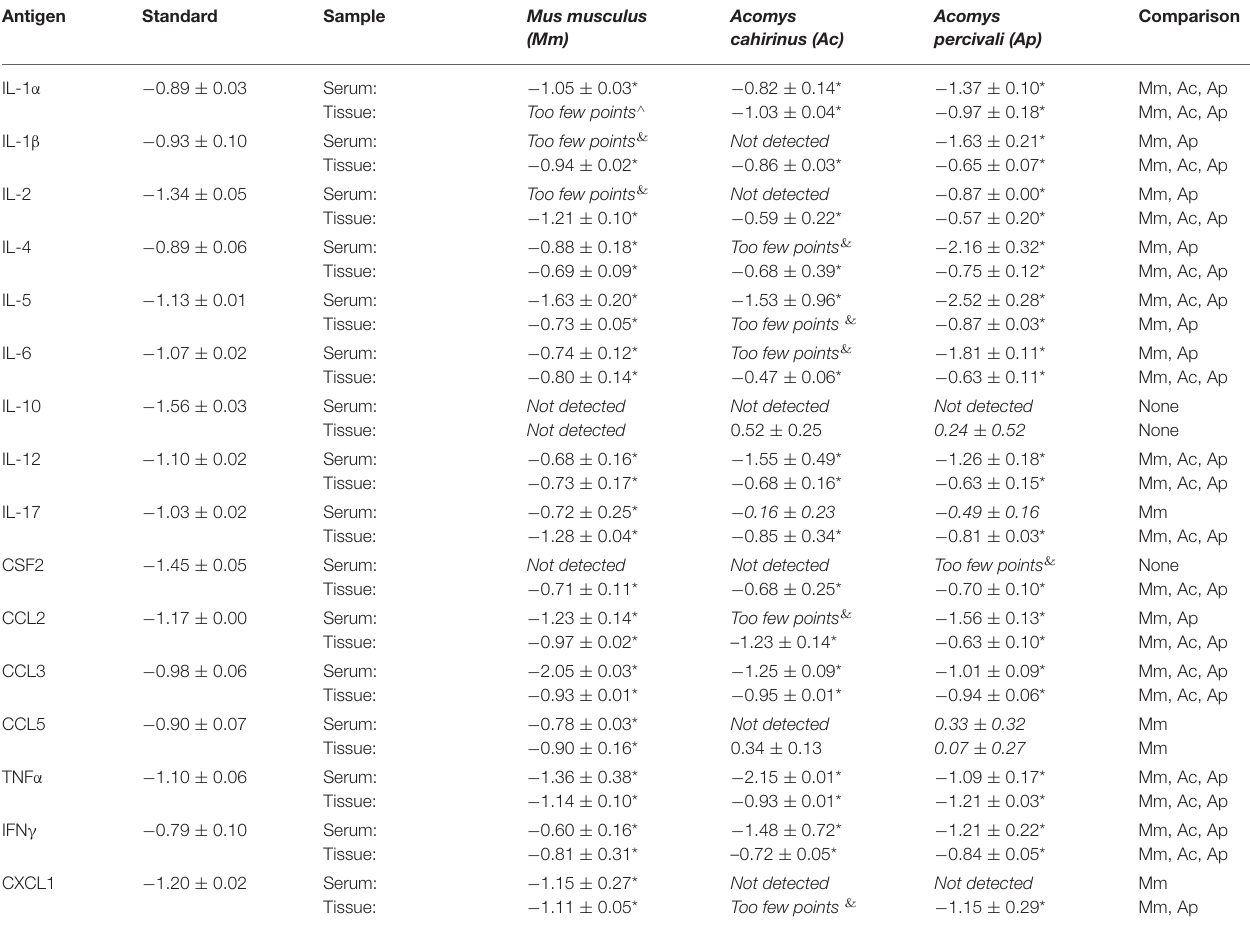
TABLE 1 | Comparison of cytokine slopes from parallelism test of cytokine assay. Antigen Standard Sample Mus musculus